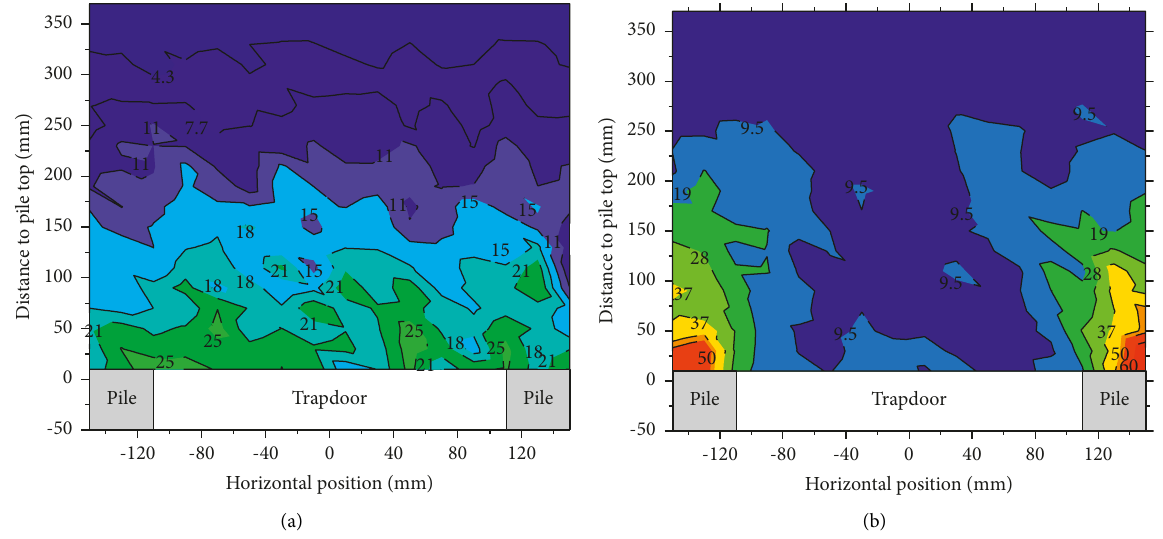
Figure 10: Vertical stress contour: (a) before trapdoor displacement and (b) after trapdoor